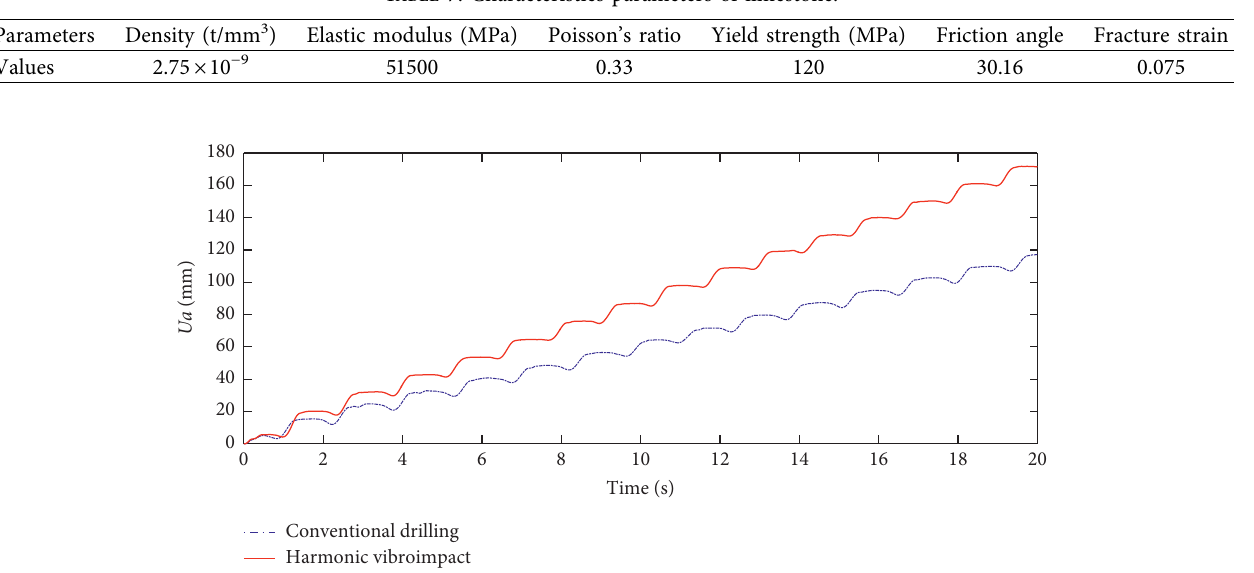
Table 7: Characteristics parameters of limestone.